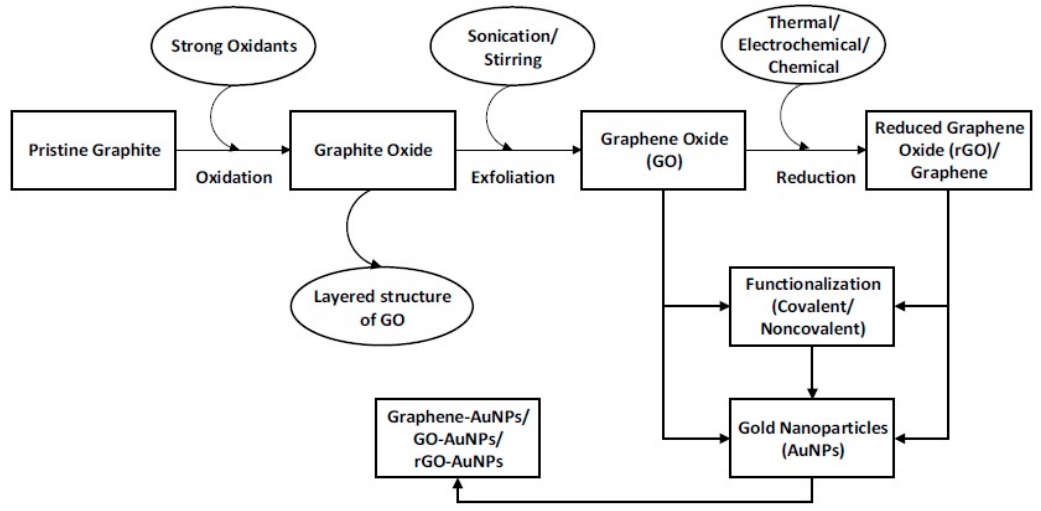
Figure 1. Process flowchart of metal–graphene nano-composite preparation (Reprinted (adapted) with permission from [2]; Authors Copyright © 2016, MDPI).